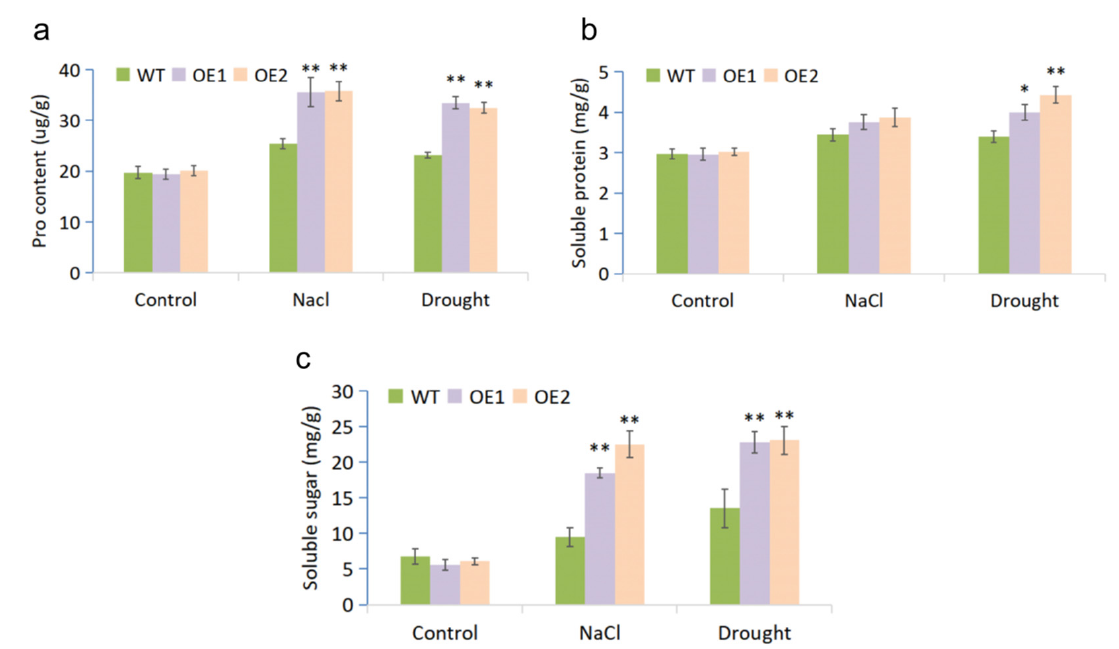
Figure 4. Evaluation of physiological indices responsive to stress. Proline content ( a ), soluble protein content ( b ) and soluble sugar content ( c ) were measured in OE lines and WT plants. Samples used for measurements were leaves of plants treated by drought (stopping watering 4-week-old plants for 10 days) and salt (irrigating 4-week-old plants using 300 mM NaCl solution for 7 days) stresses. Each measurement was performed in three replicates. The data are shown as mean and SD (bars) of three biological replicates, and the asterisk indicated the significant difference (* p < 0.05; ** p < 0.01).